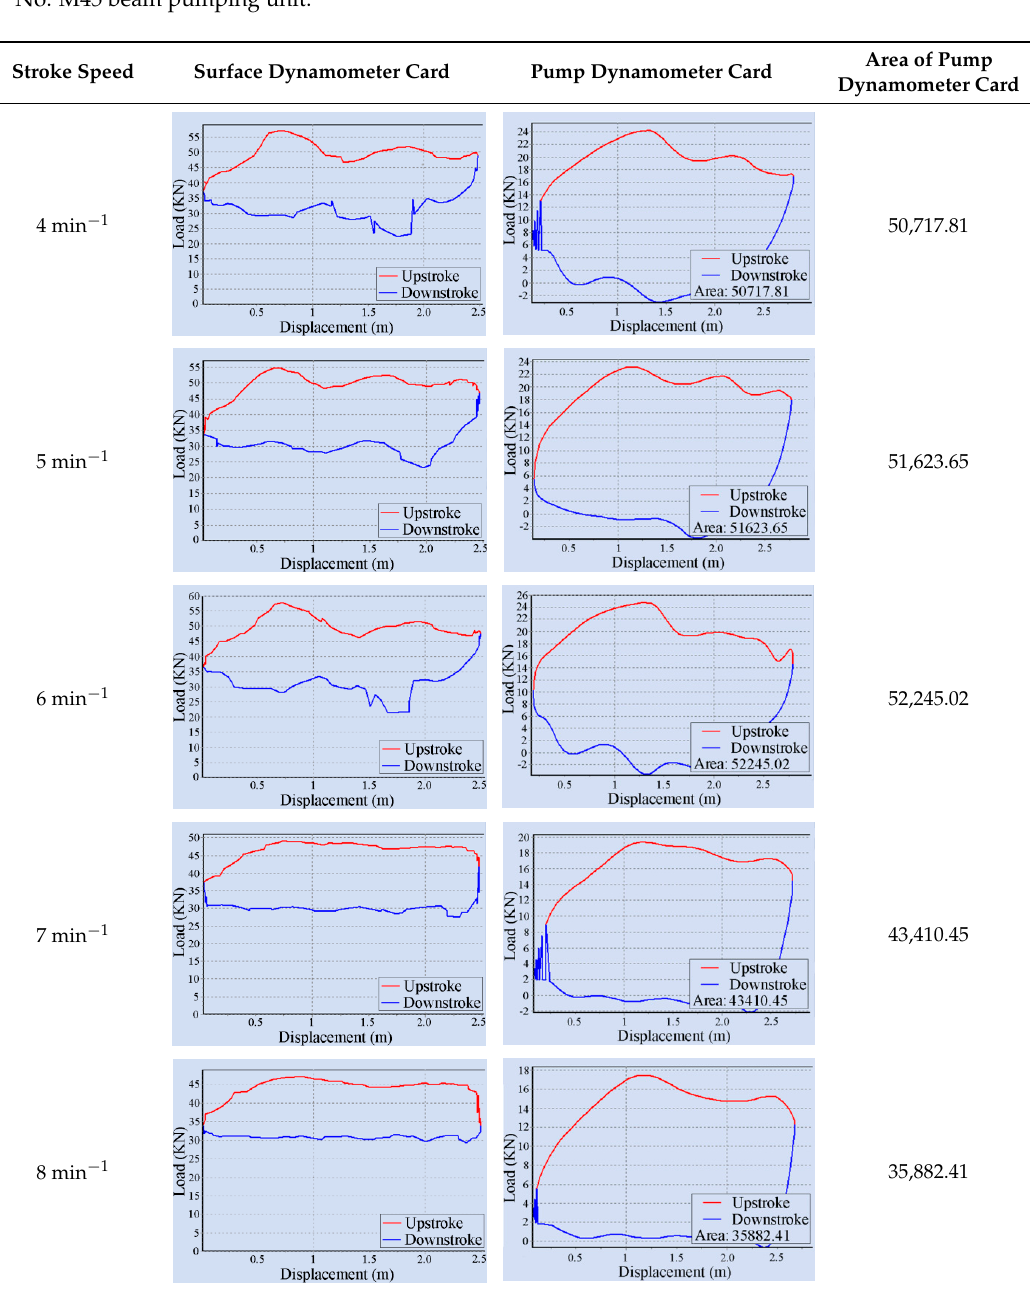
Table 2. Results of the automatic stroke speed adjustment using this energy saving system on the No. M45 beam pumping unit.